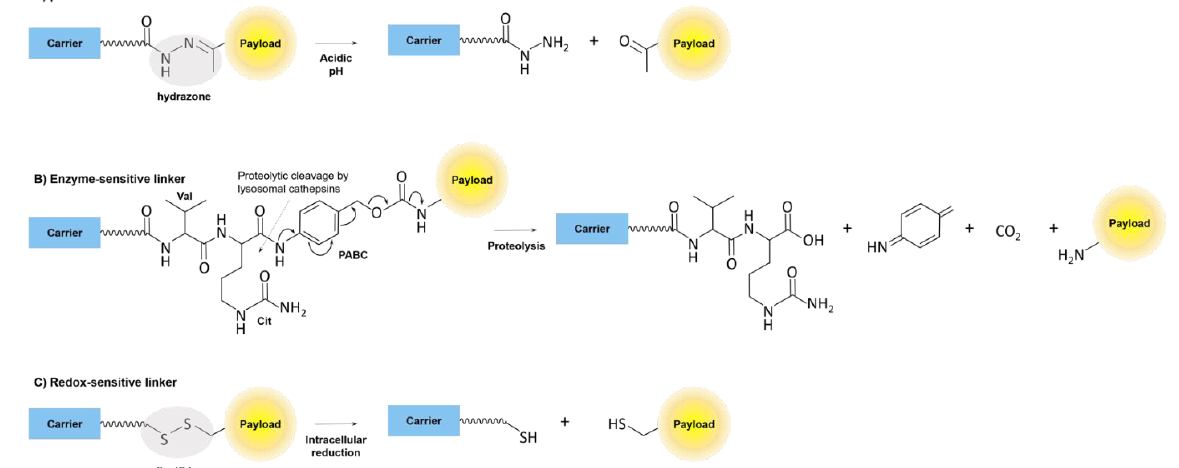
Figure 4. Cleavable linkers. ( A ) A prototypical pH-sensitive linker contains a hydrazone moiety, which is cleaved in an acidic environment such as within an endosome or lysosome. ( B ) An example of an enzyme-sensitive linker is the lysosomal cathepsin-sensitive valine-citrulline- p -aminobenzyloxycarbonyl (PABC) function. Chemical rearrangement and release of the PABC moiety during the cleavage reaction enables free release of the payload. ( C ) A redox-sensitive linker is exemplified by a simple disulfide bond, which is reduced by intracellular reducing agents such as glutathione to release the payload.